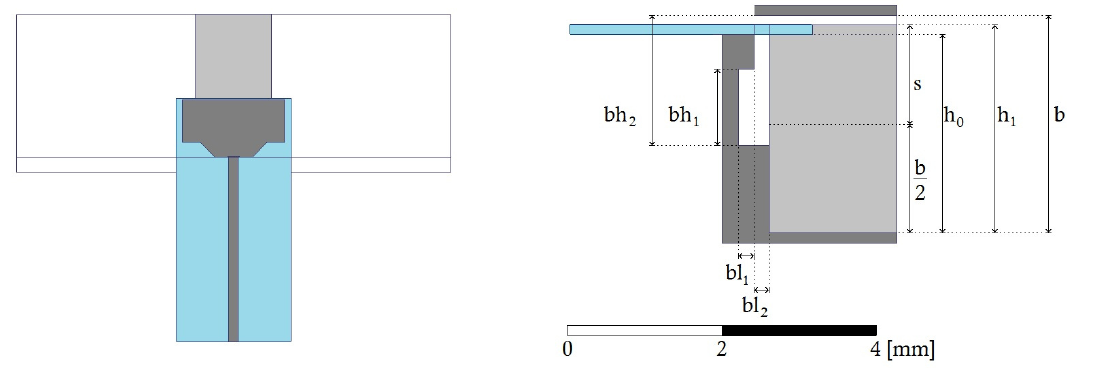
Figure 2. Geometry: top ( left ) and side ( right )